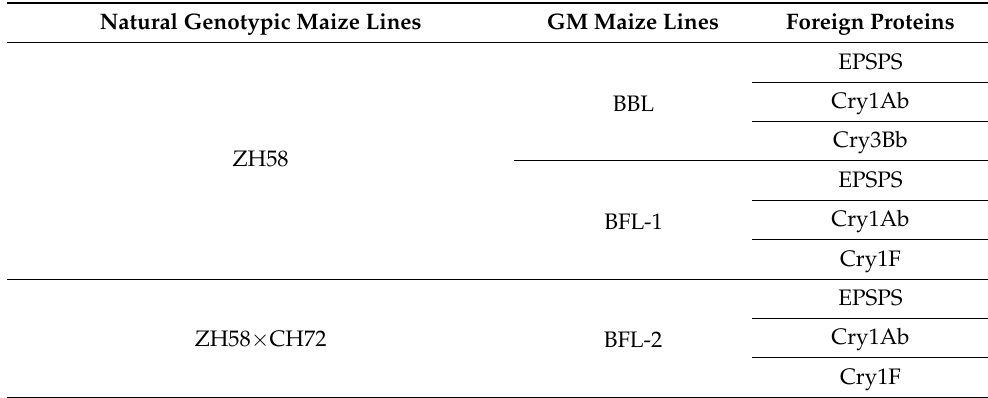
Table 1. Summary of the studied maize lines. Natural Genotypic Maize